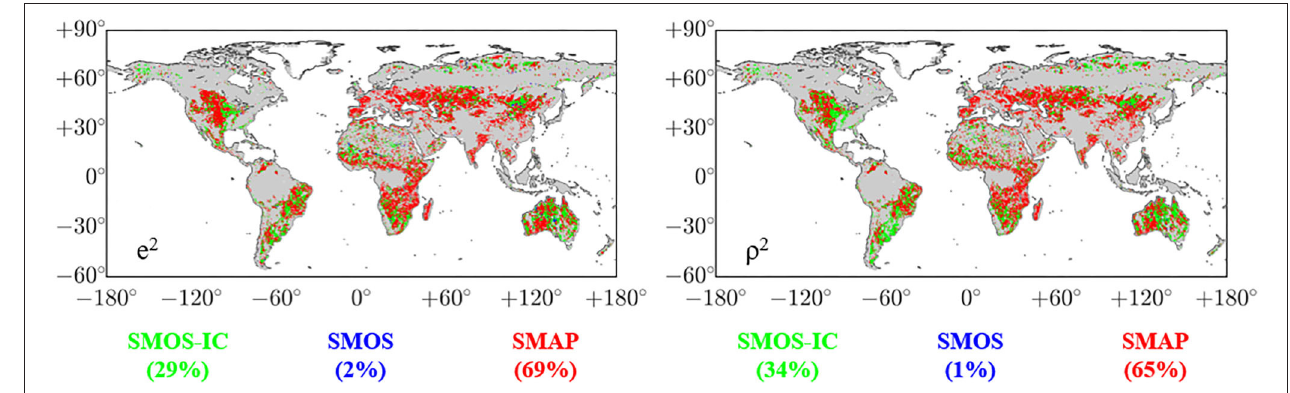
FIGURE 2 | Global rank maps showing soil moisture datasets, SMAP (red), SMOS-IC (green), and SMOS (blue), presenting the lowest error variances e 2 (Left) and the highest squared Pearson correlation coefficients ρ 2 (Right) . Here, the numerical values in parentheses represent proportions in percentages that the three soil moisture datasets show the lowest (highest) e 2 ( ρ 2 ). Here the gray background on land indicates regions masked by the data preprocessing described in section